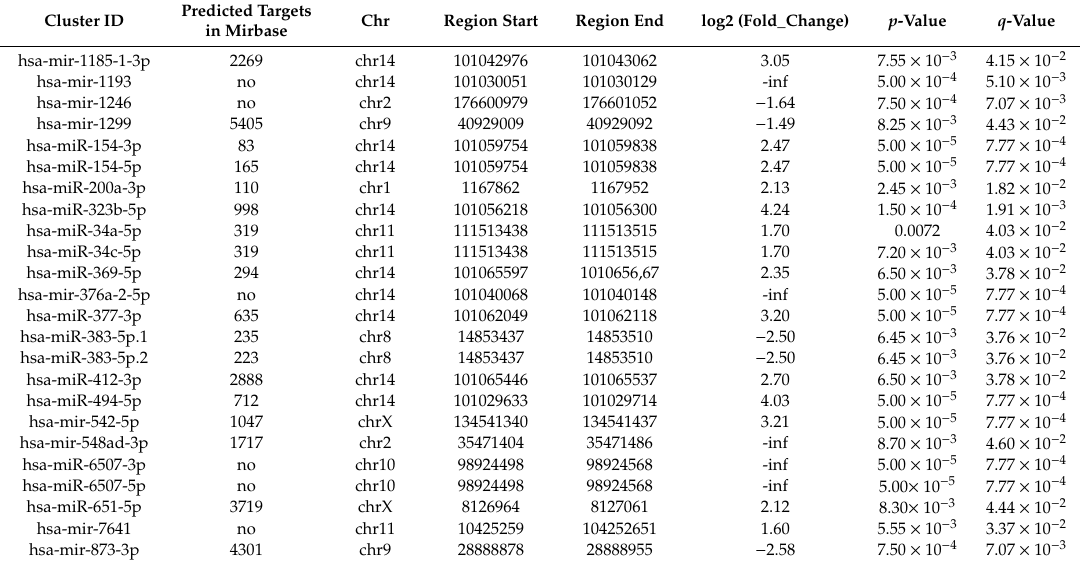
Table 2. microRNAs (miRNAs) potentially regulated in PHV as compared to no PHV by a di ff erential expression analysis (Cu ffl